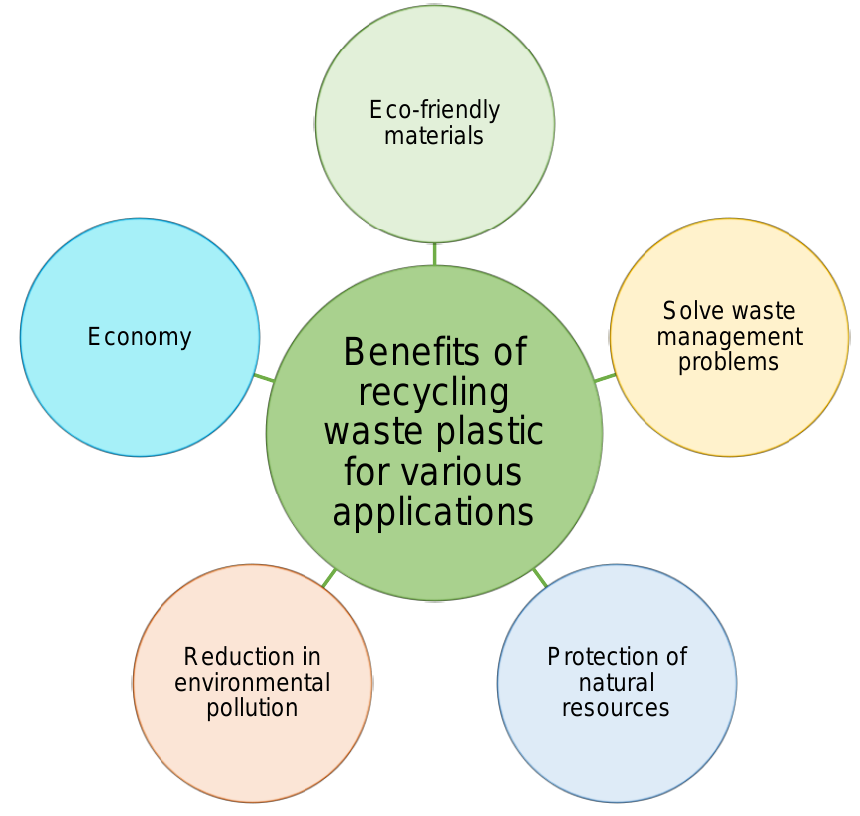
Figure 15. Advantages of plastic waste recycling and reuse.